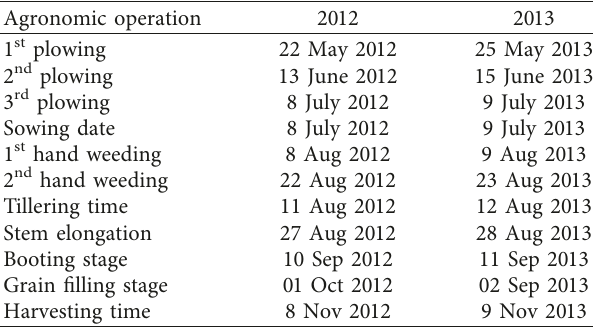
Table 1: Dates of agronomic practices and different growth stages of tef crops in 2012 and 2013 cropping